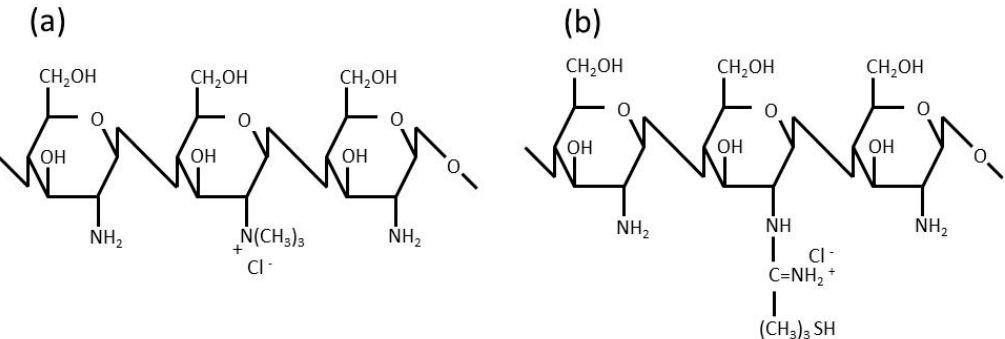
Figure 1. Chemical structures of ( a ) trimethyl-chitosan (TMC); and ( b ) chitosan-4-thio-butylamidine conjugate (Ch-TBA).